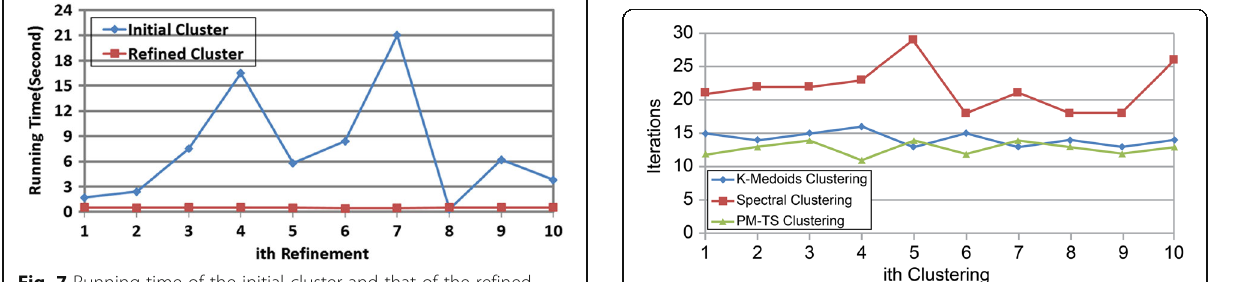
Fig. 7 Running time of the initial cluster and that of the refined cluster after running Tabu Search ten times